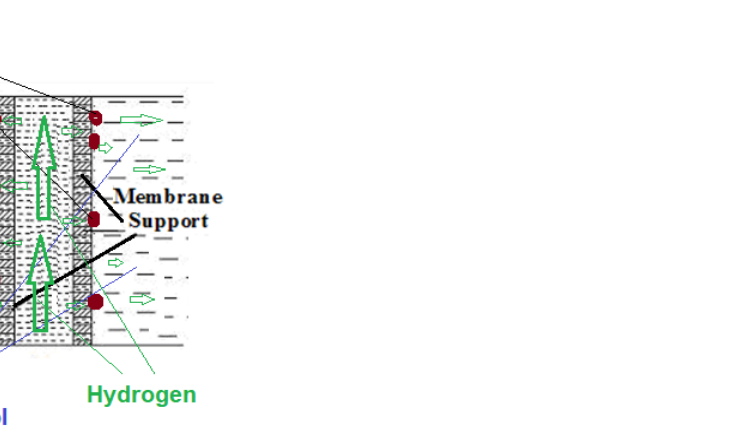
Figure 6. Schematic presentation of the contactor for reducing osmium tetroxide dissolved in tert- butyl alcohol at aggregates of metallic osmium nanoparticle with molecular hydrogen.